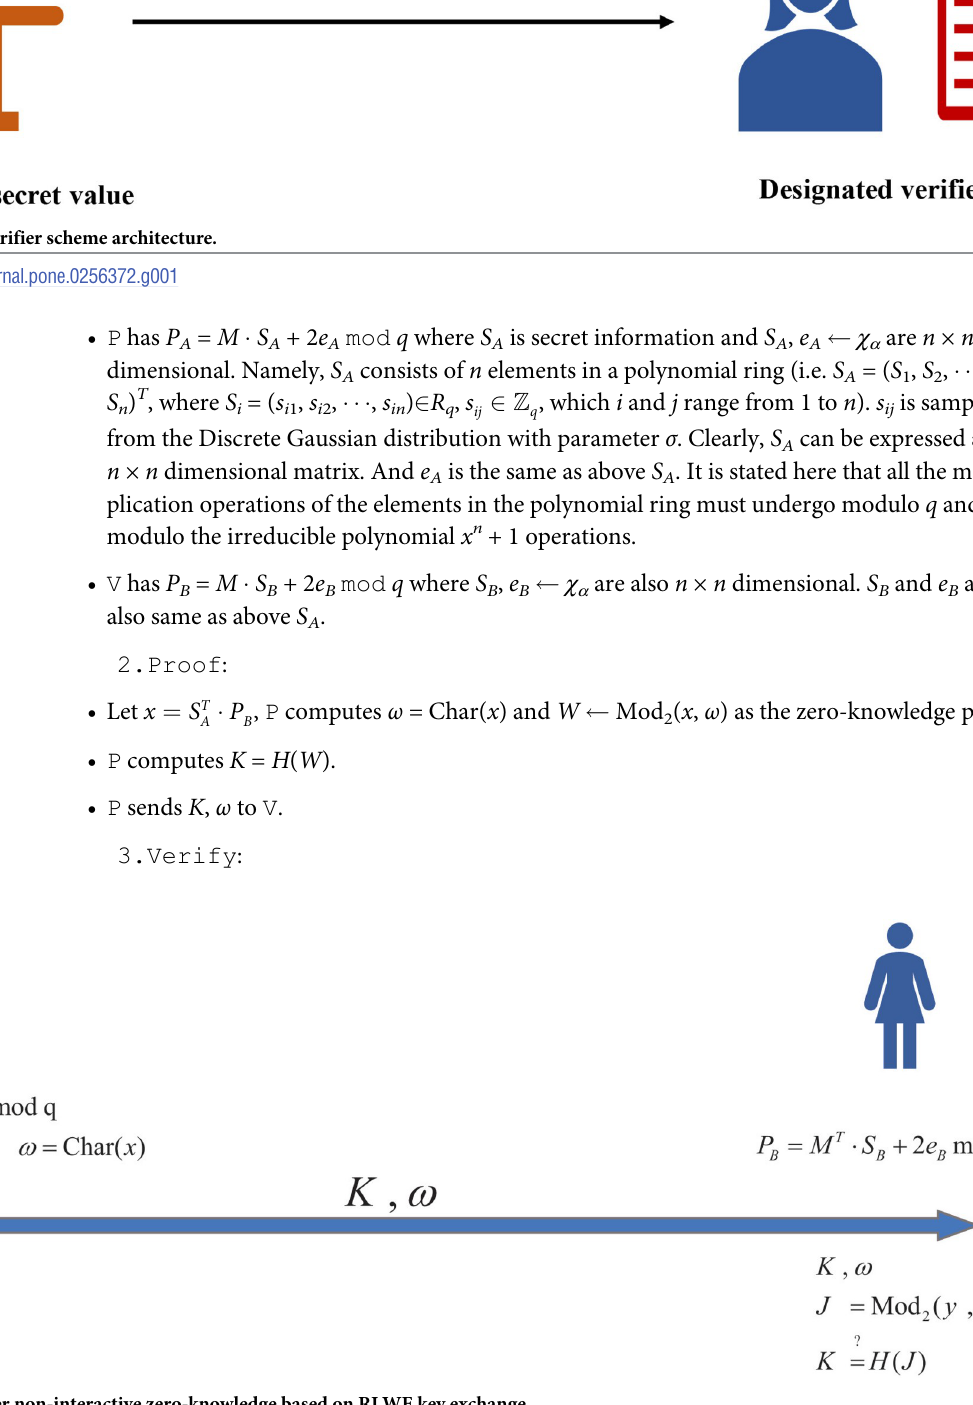
Fig 2. Designated-verifier non-interactive zero-knowledge based on RLWE key exchange.